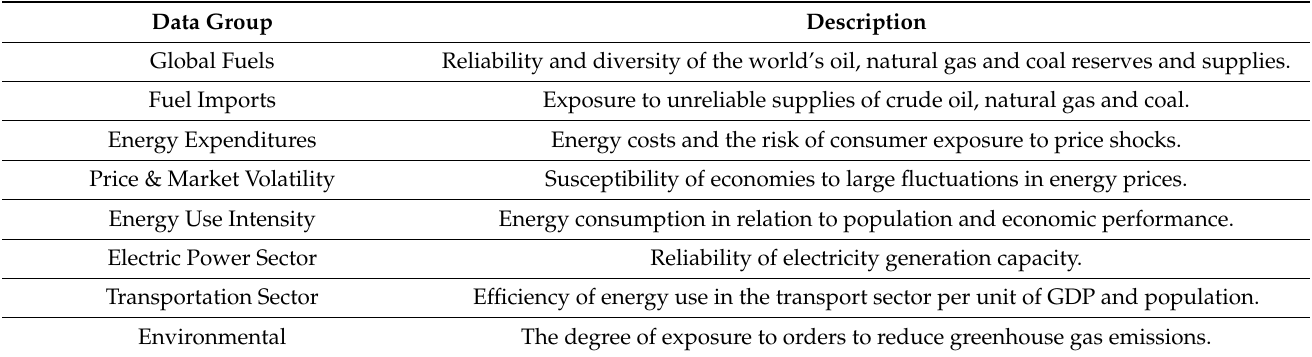
Table 2. The importance of individual groups of data included in the IESRI